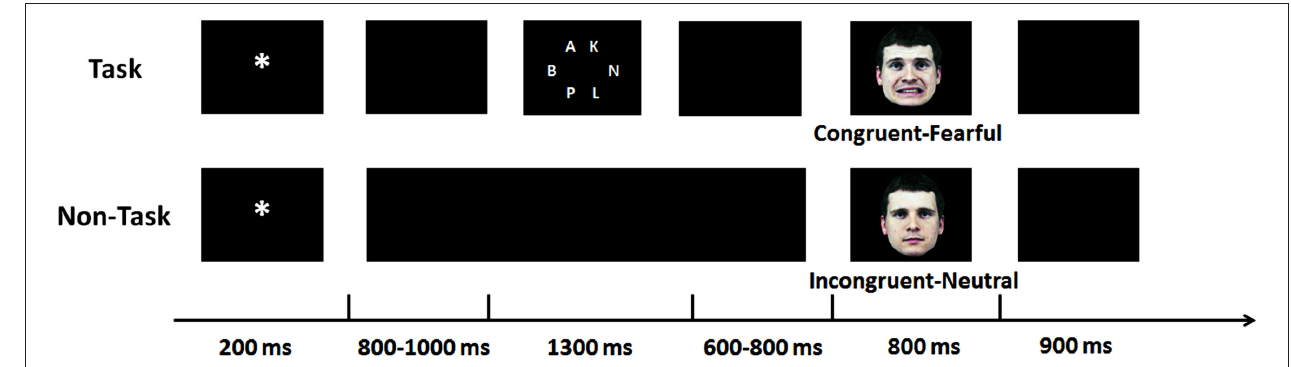
FIGURE 1 | Experimental procedure. A cue-face paradigm was performed with a cognitive task between the cue and the face (the upper panel) and without (the lower panel).